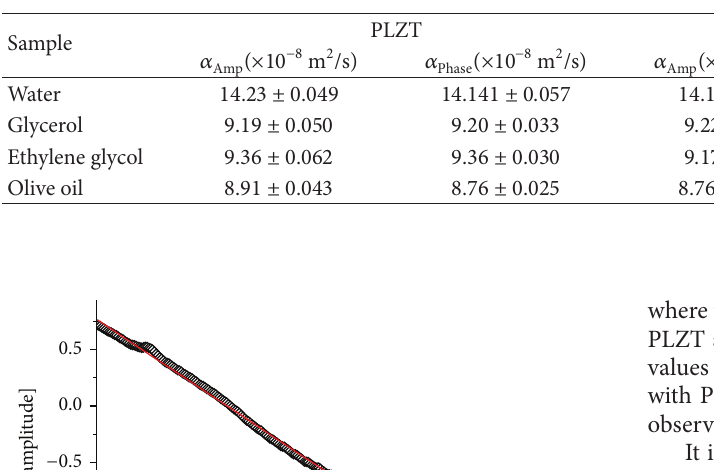
Table 1: Thermal diffusivities of analyzed liquids.